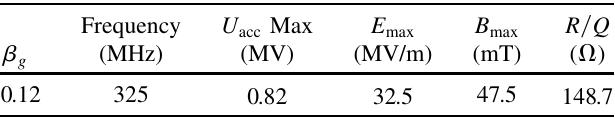
TABLE IV. Main design parameters of the Spoke012 cavity for the injector.